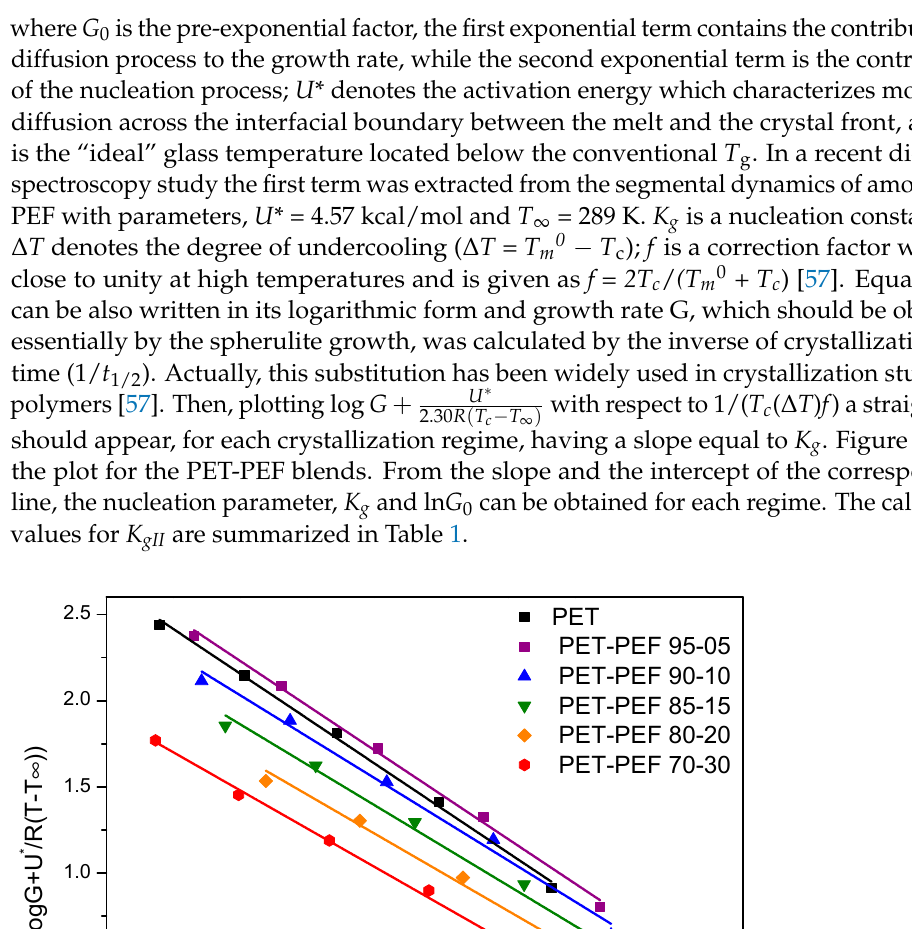
Figure 8. Lauritzen Hoffman-plots for PET and the blends. Table 1. Results from the Lauritzen-Hoffman analysis on the crystallizable blends.